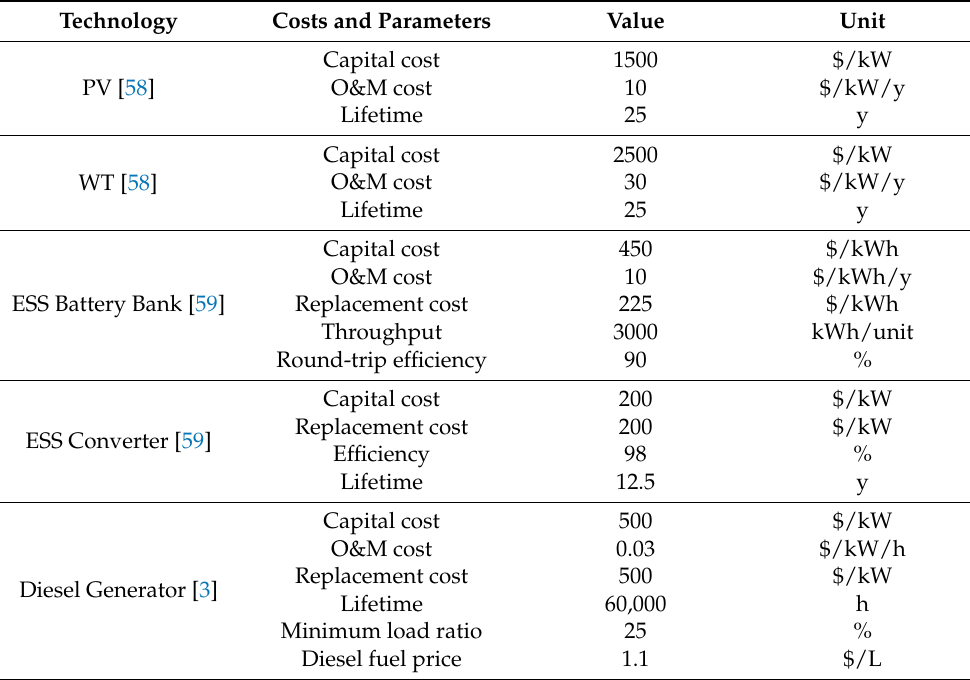
Table 3. Associated costs and parameters of DER